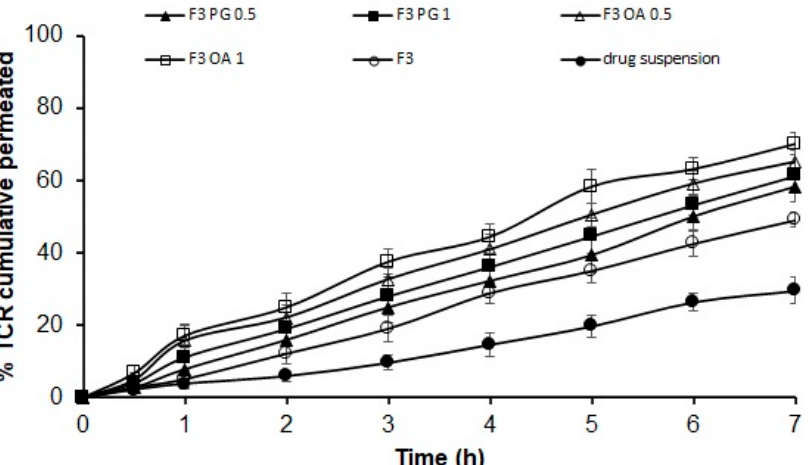
Figure 4. Ex vivo permeation data of different permeation enhancers containing TCR-loaded SPLs. Results ( n = 3) are presented as mean ± SD.